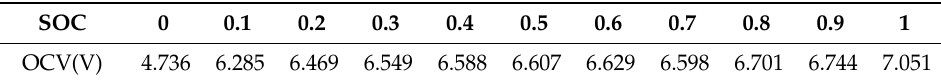
Table 4. OCV at di ff erent